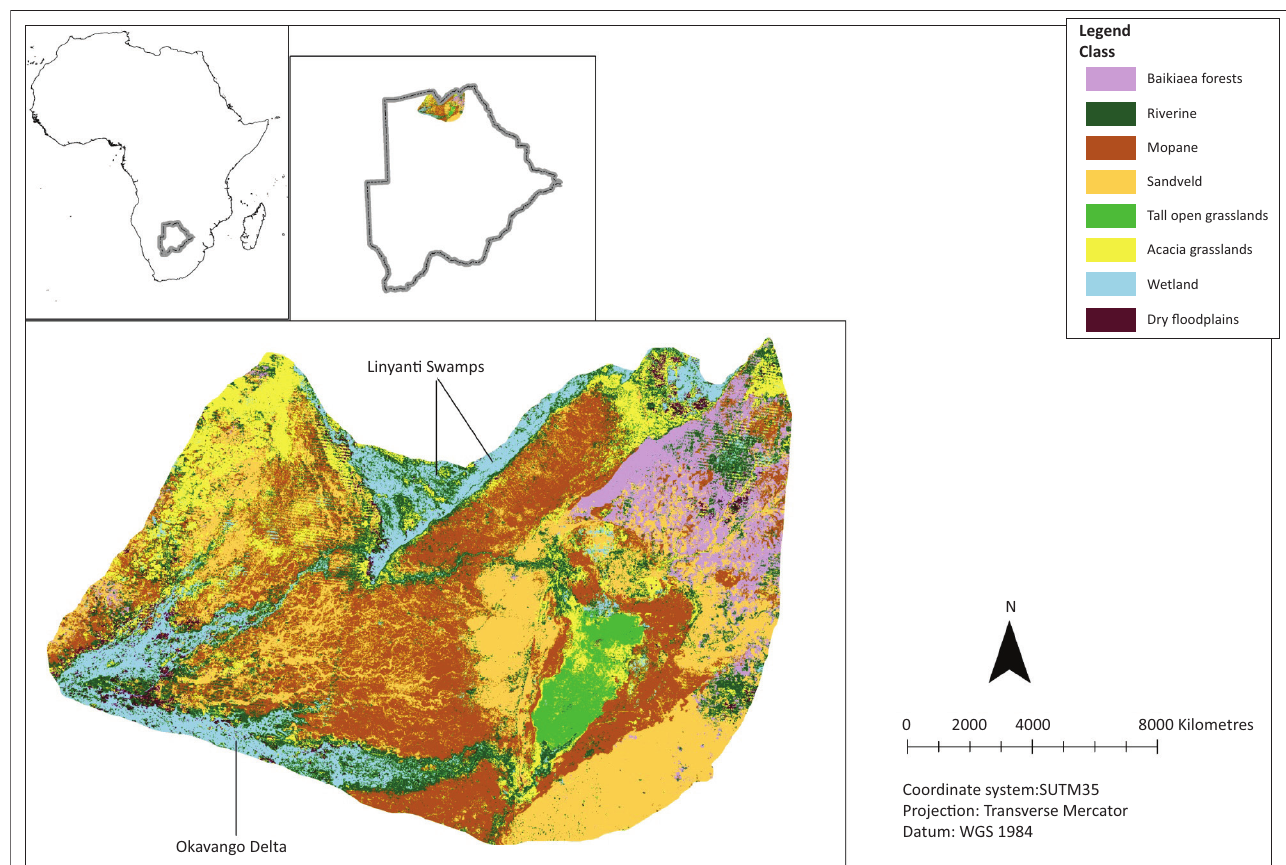
FIGURE 1: Savuti–Mababe–Linyanti ecosystem